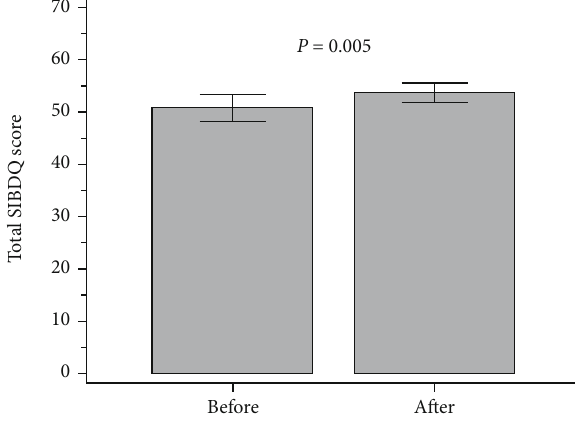
Figure 1: Total SIBDQ scores before and after treatment. Table 3: SIBDQ scores before and after probiotic